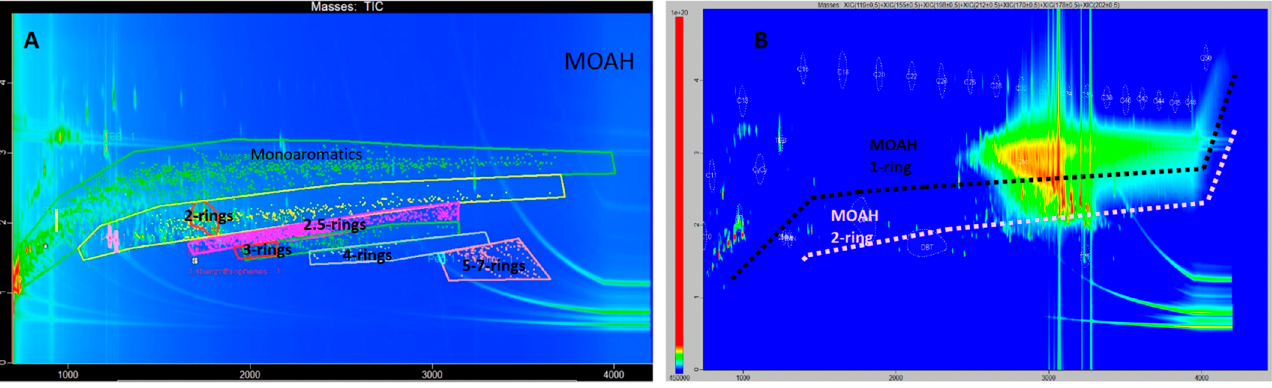
Figure 3. ( A ) Total ion current (TIC) two-dimension chromatogram for the MOAH fraction of a mixture of mineral oils from different origins, obtained by LC-GCxGC-TOF-MS, used for comparisons. ( B ) Extracted ion chromatogram of the MOAH fraction of an olive pomace oil sample corresponding to m/z 119, 155, 198, 170, 178, and 202.